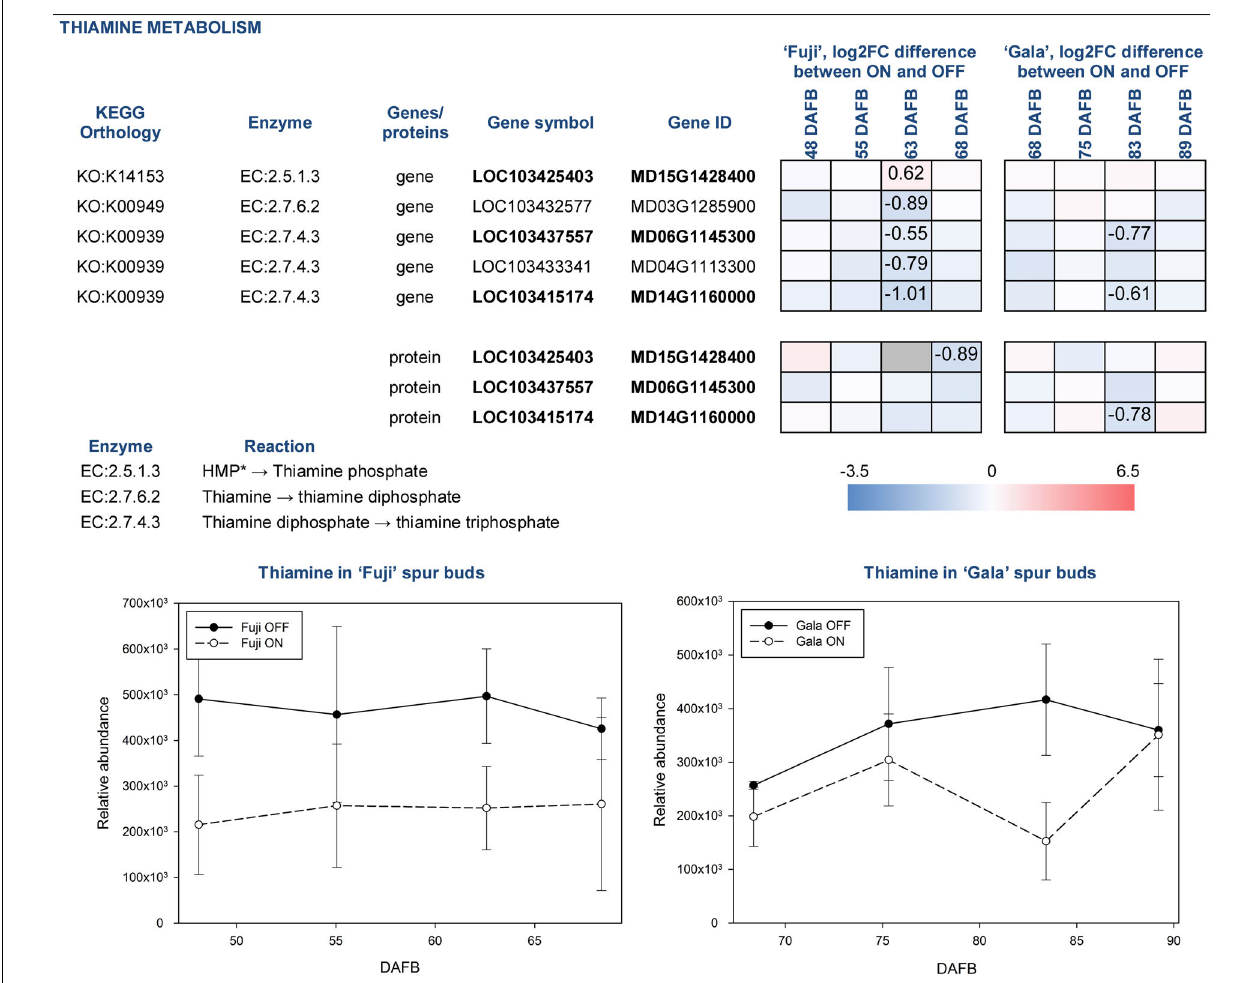
FIGURE 7 | Relative abundance of thiamine in spur buds from ‘Fuji’ and ‘Gala’ with differently expressed genes (DEGs) between ON- and OFF-trees and corresponding proteins, which are assigned to the enzymatic reactions metabolizing the compound. *HMP—4-amino-5-hydroxymethyl-2-methylpyrimidine diphosphate. Information about the reactions and genes assigned to thiamine metabolism was provided from KEGG library. Bold font of gene and protein IDs indicates a link between a gene and a corresponding protein illustrated in the figure. Negative log2FC values (blue) indicate a higher gene expression or higher protein abundance in OFF, positive log2FC values (red)—in ON. Cells of the same color on the heat map indicate the same level of log2FC gene (protein) expression difference between ON- and OFF-trees and do not indicate significant differences. Numbers on the heat map specify exact log2FC differences between ON- and OFF-trees and mark significant differences at multiple adjusted p ≤ 0.05. Gray cells indicate no statistics possible due to “fill gap” function switched off (see Materials and